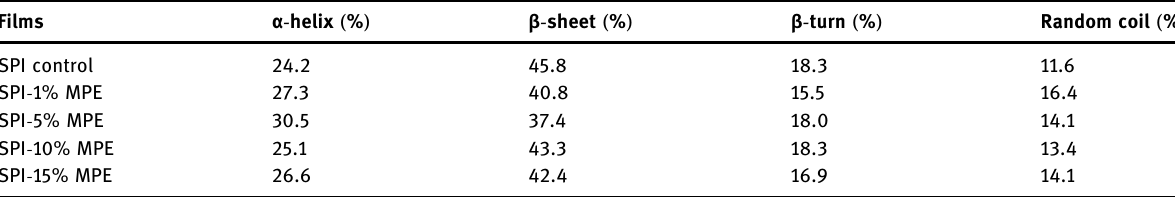
Table 8: Percentage of secondary structures of SPI fi lms with and without MPE Films